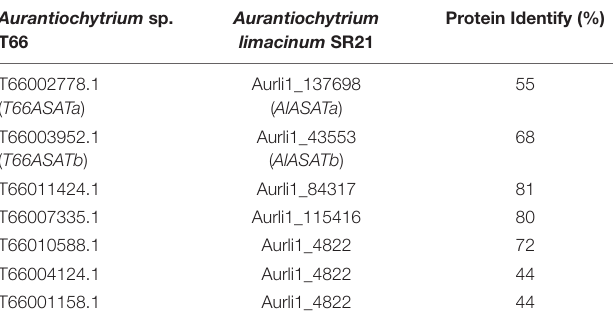
TABLE 1 | Putative DGAT- like encoding genes in T66 (Heggeset et al., 2019), and their homologs in SR21 (JGI MycoCosm database). Aurantiochytrium sp.